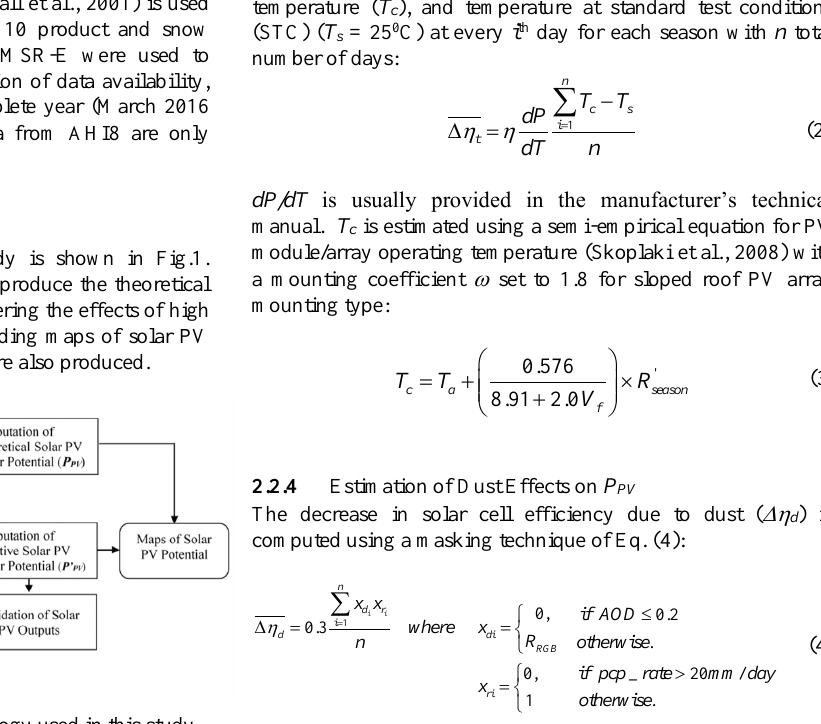
Figure 1. The flowchart of the methodology used in this